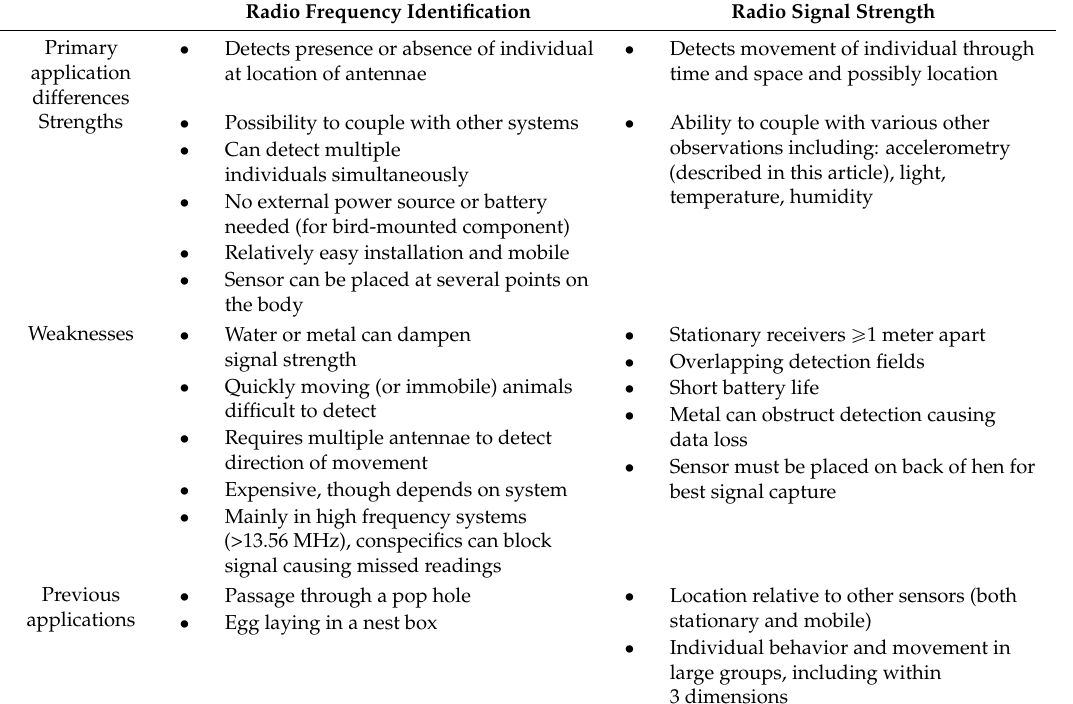
Table 1. Summary of strengths, weaknesses, primary and previous applications of radio frequency identification and radio signal strength systems used in laying